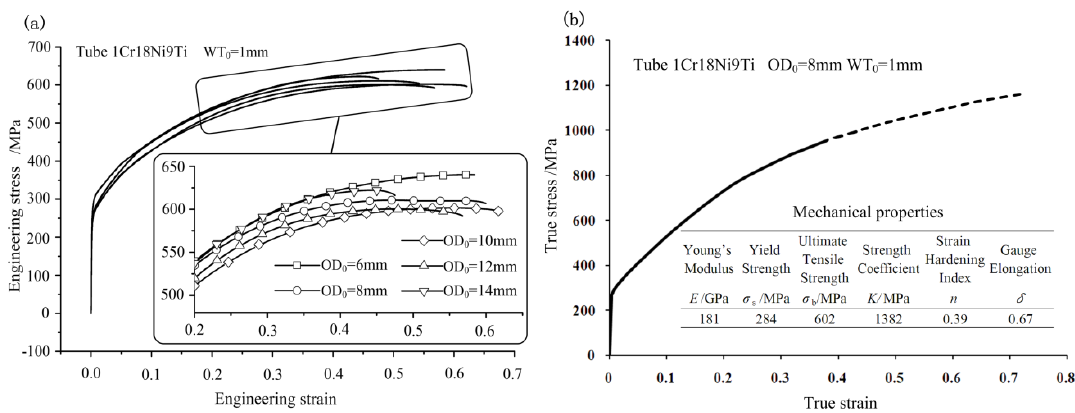
Figure 2. Material properties: ( a ) Engineering stress–strain curves of different sizes 1Cr18Ni9Ti tubes; ( b ) True stress–strain curve and mechanical properties of 1Cr18Ni9Ti with OD 0 = 8 mm WT 0 = 1.